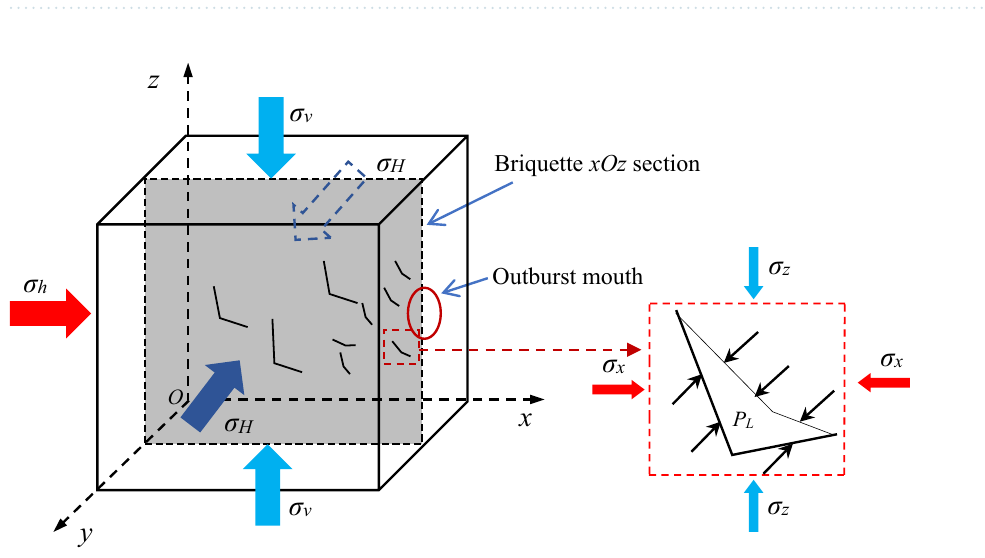
Figure 13. Initial failure of gas-bearing coal.